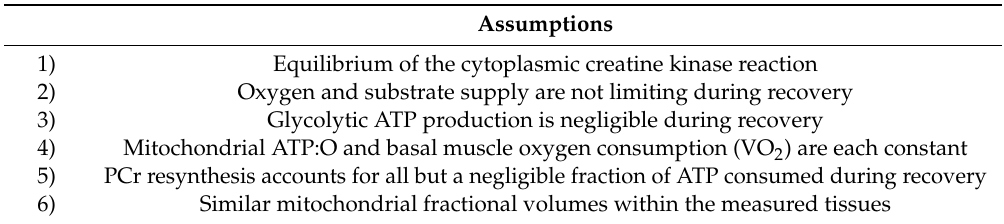
Table 1. Underlying assumptions for using the phosphocreatine (PCr) recovery time constant to infer mitochondrial function